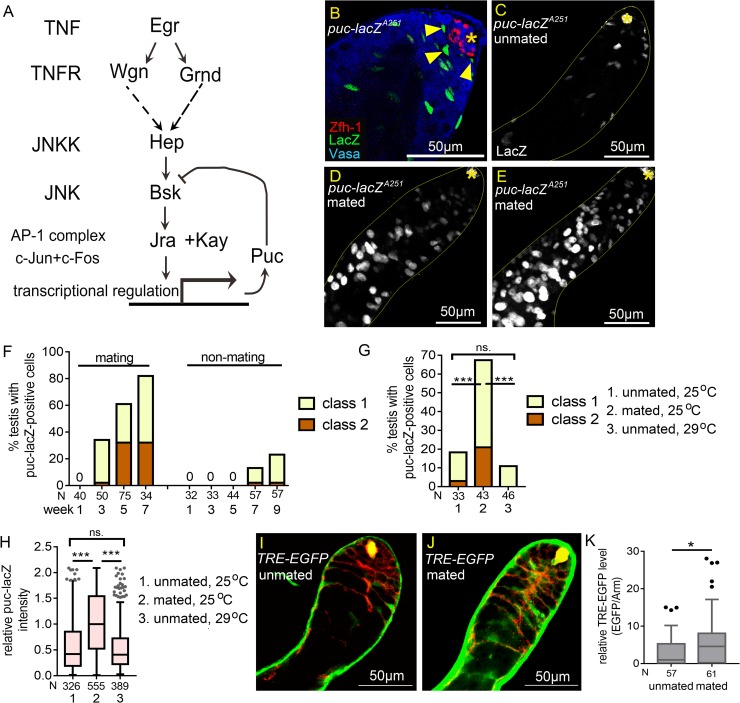
JNK signaling is hyperactivated in somatic cyst cells in mated testes.(A) Diagram of JNK signaling pathway. (B) Testis from 3-day-old puc-lacZA251 male immunostained for β-galatosidase (green), co-stained for Zfh-1 (red) and Vasa (blue). Arrowheads indicate the LacZ-positive early cyst cells. (C-E) Testes from 4w-old puc-lacZA251 males immunostained for β-galactosidase, co-stained for FasIII (asterisks). Testes exhibiting class 1 and class 2 of extra puc-lacZ-positive cells are shown in D and E. (F) The percentages of testes with extra puc-lacZ-positive cells were much higher in mated males than unmated males. N: number of testes scored. (G) Percentages of 4w-old testes with extra puc-lacZ-positive cells. Overproduction of puc-lacZ-positive cells was observed in mated testes, but not in unmated testes at both 25°C and 29°C. N: number of testes scored. (H) Box-and-whisker plots showing the relative anti-β-galactosidase intensity in single early cyst cells in 4w-old puc-lacZ testes. N: number of the puc-lacZ-positive cells scored. (I-K) Testes of TRE-EGFP immunostained for GFP (green), co-stained for Arm (red). (I and J) Reduced TRE-EGFP expression in cyst cells of the unmated 4w-old males (I) compared to the mated 4w-old males (J). (K) The relative TRE-EGFP intensity in early cyst cells of unmated and mated 4w-old males. N: number of the cyst cells scored. P-values were calculated by Mann-Whitney test in H and K, and by Chi-squared test in G, and P. ns: p>0.05, *p<0.05, **p<0.01, and ***p<0.001. Asterisks indicate the hubs. Mass-mating was conducted for experiments shown in D-H, J, and K. Unmated of 30 males per vial was in C, F, G, H, I, and K.